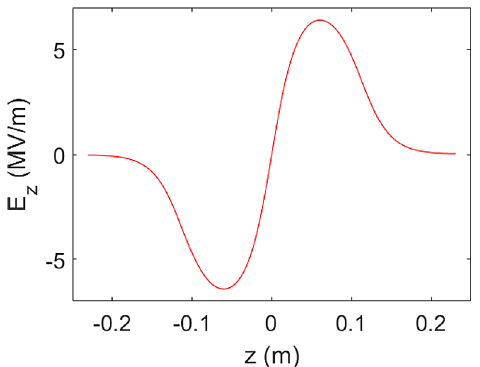
FIG. 14. Longitudinal component of the electric fields in the cavities.